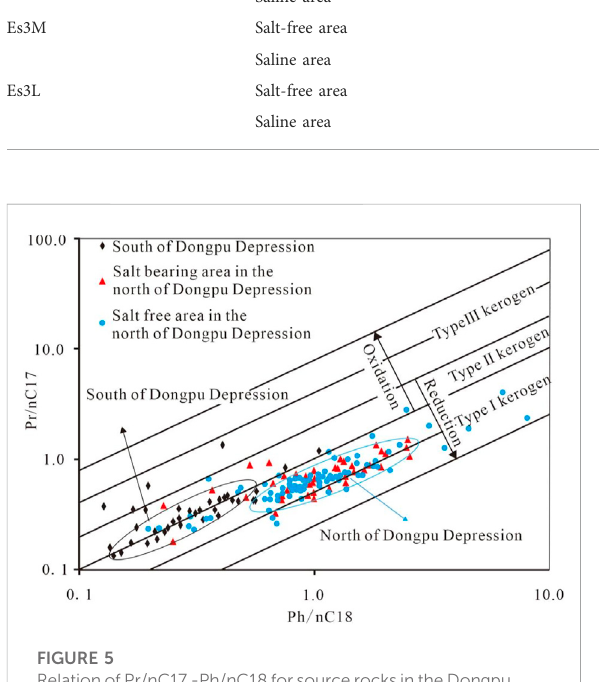
FIGURE 5 RelationofPr/nC17-Ph/nC18forsourcerocksintheDongpu